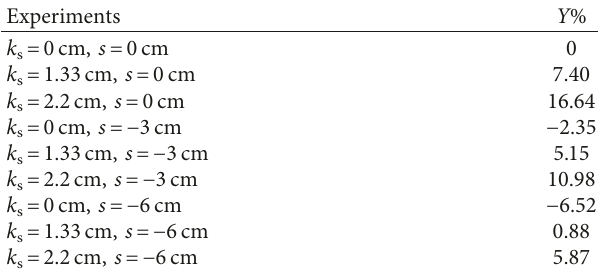
Table 1: The average dimensionless depth deficit parameter ( Y %). Experiments